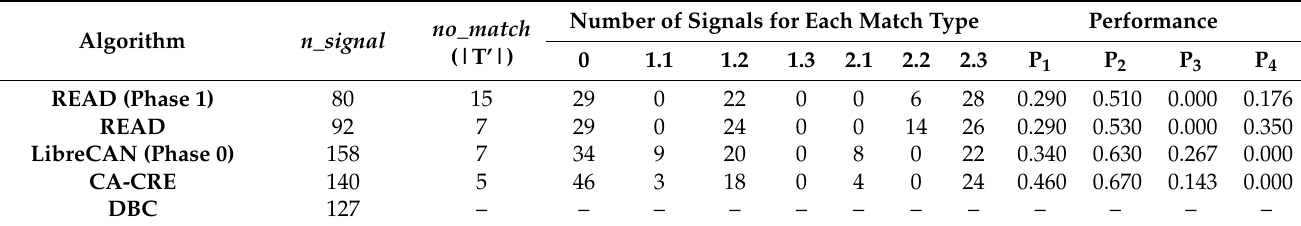
Table 11. Comparison of the four algorithms on the real CAN dataset.